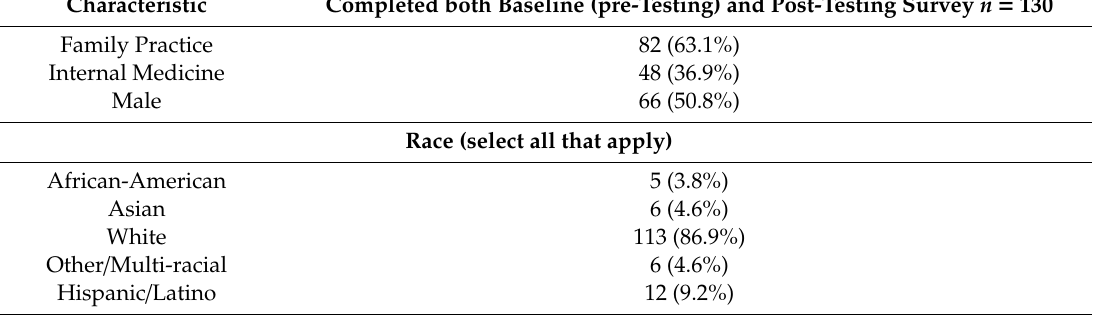
Table 1. Characteristics of study